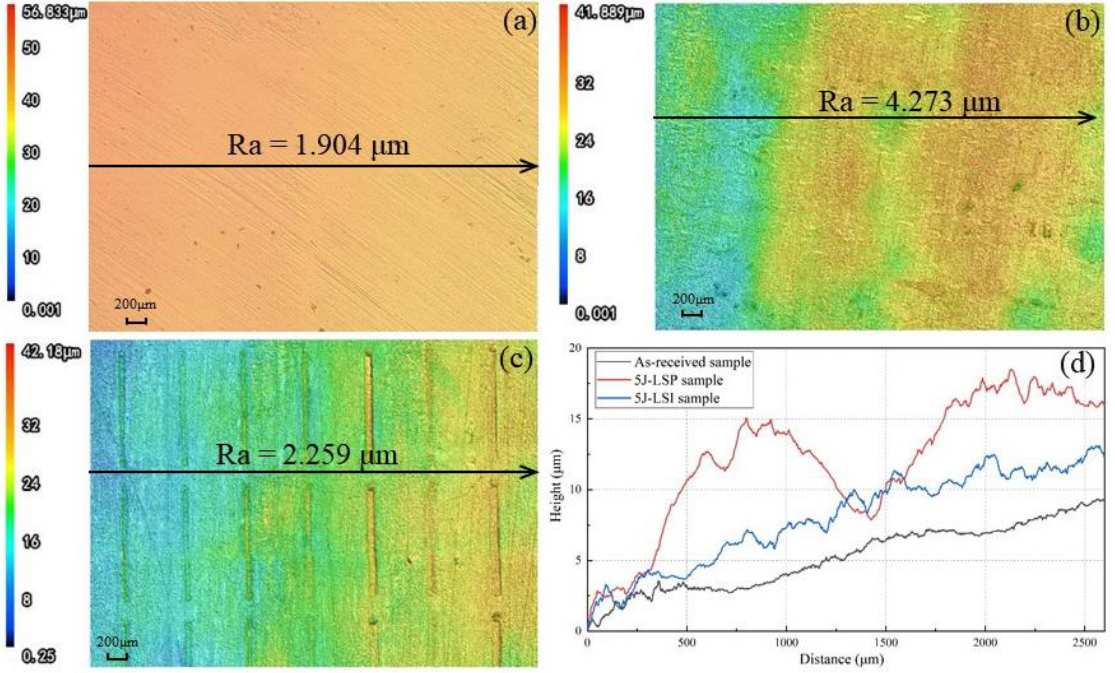
Figure 12. Surface morphology of ( a ) as-received, ( b ) 5 J LSP and ( c ) 5 J LSI samples, and ( d ) profiles.